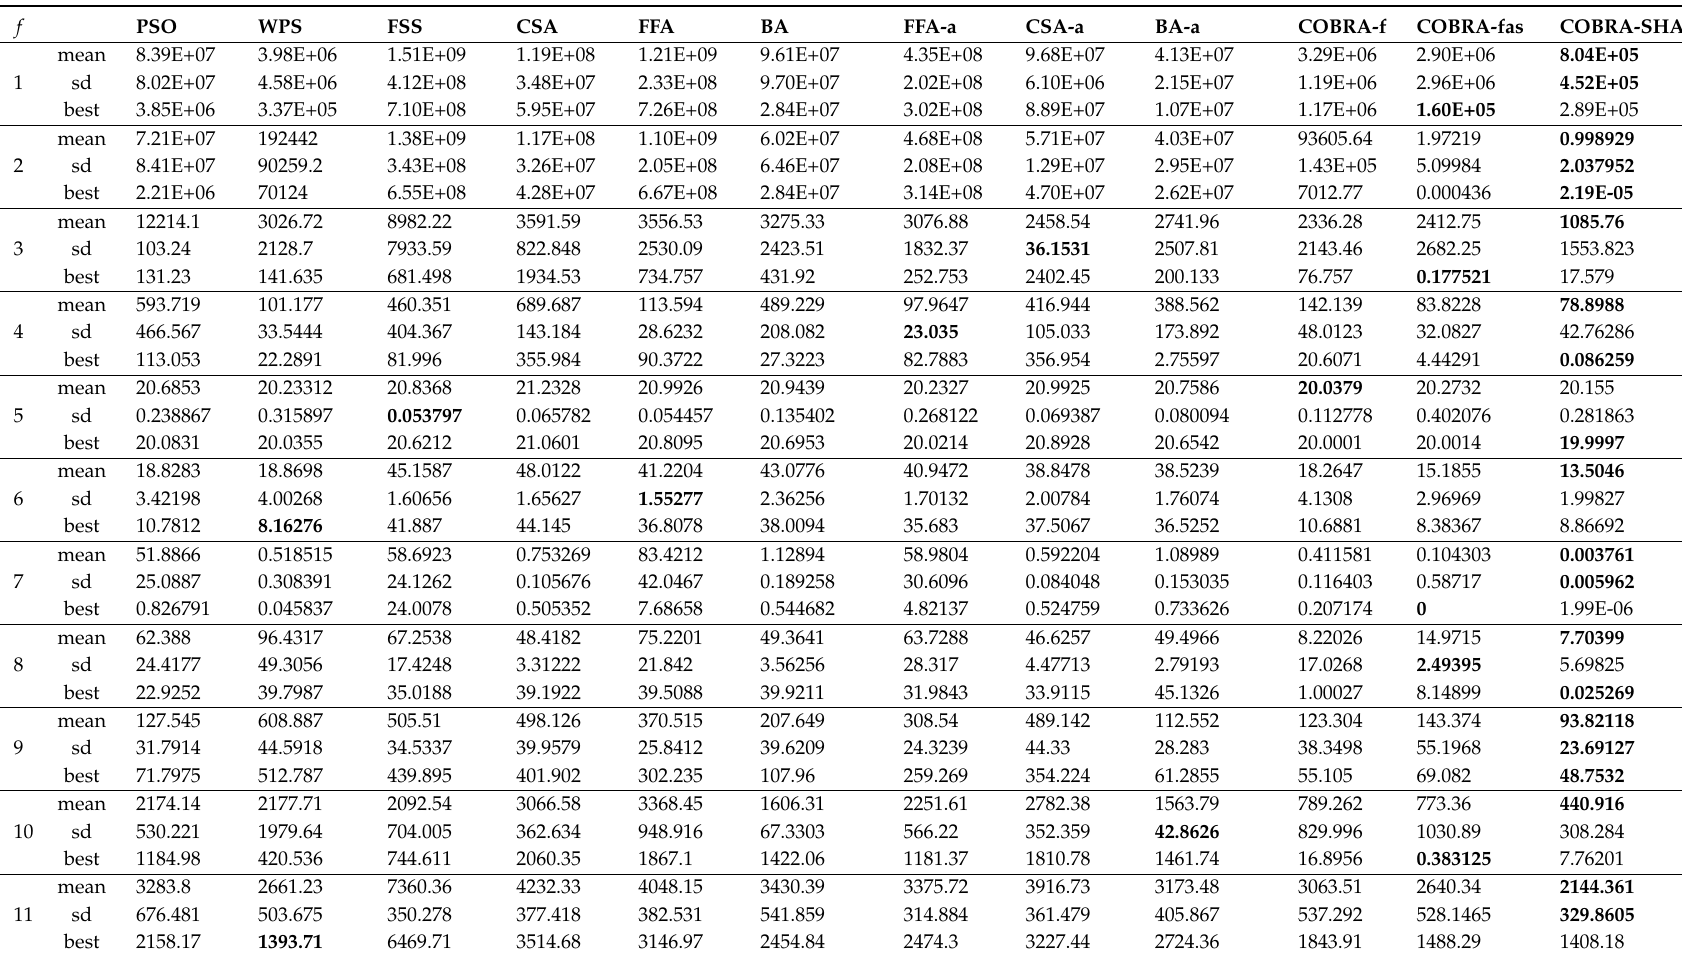
Table 7. Minimization results of 16 benchmark functions from SET-3 for compared